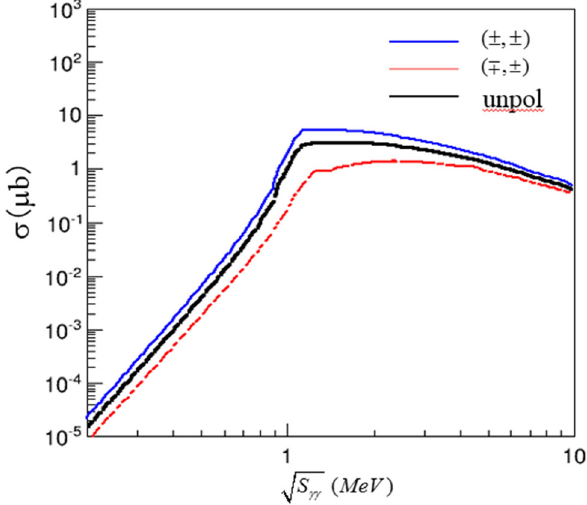
Fig. 1 Cross-section of the process, γγ → γγ , by the collision of circularly polarized photons based on the formulas in [2,3]; ( ± , ± ) and ( ± , ∓ ) stand for the combination of the helicities of the two colliding photons